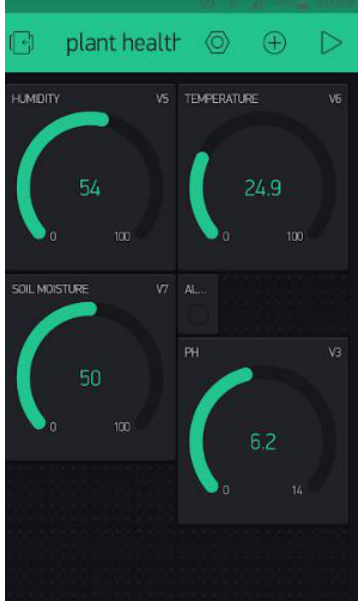
Figure 22. Blynk plant health